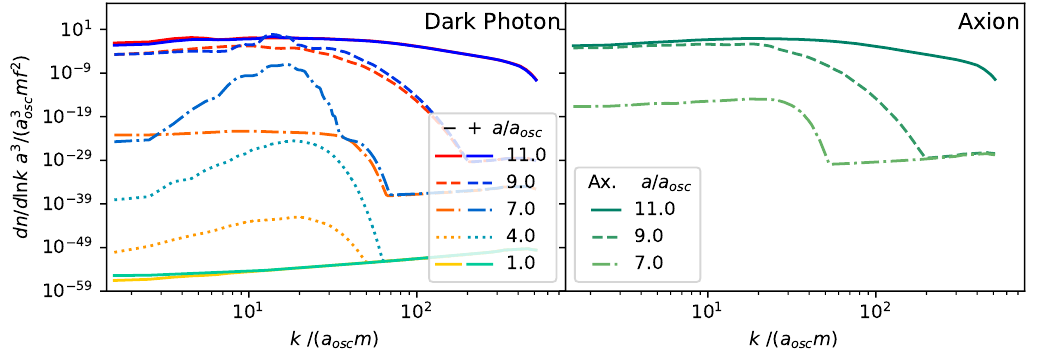
Figure 2: Early evolution of the dark photon (left) and axion (right) spectra. The model parameters are α = 60 and θ = 1. The “ + " polarization is the first to experi- ence tachyonic